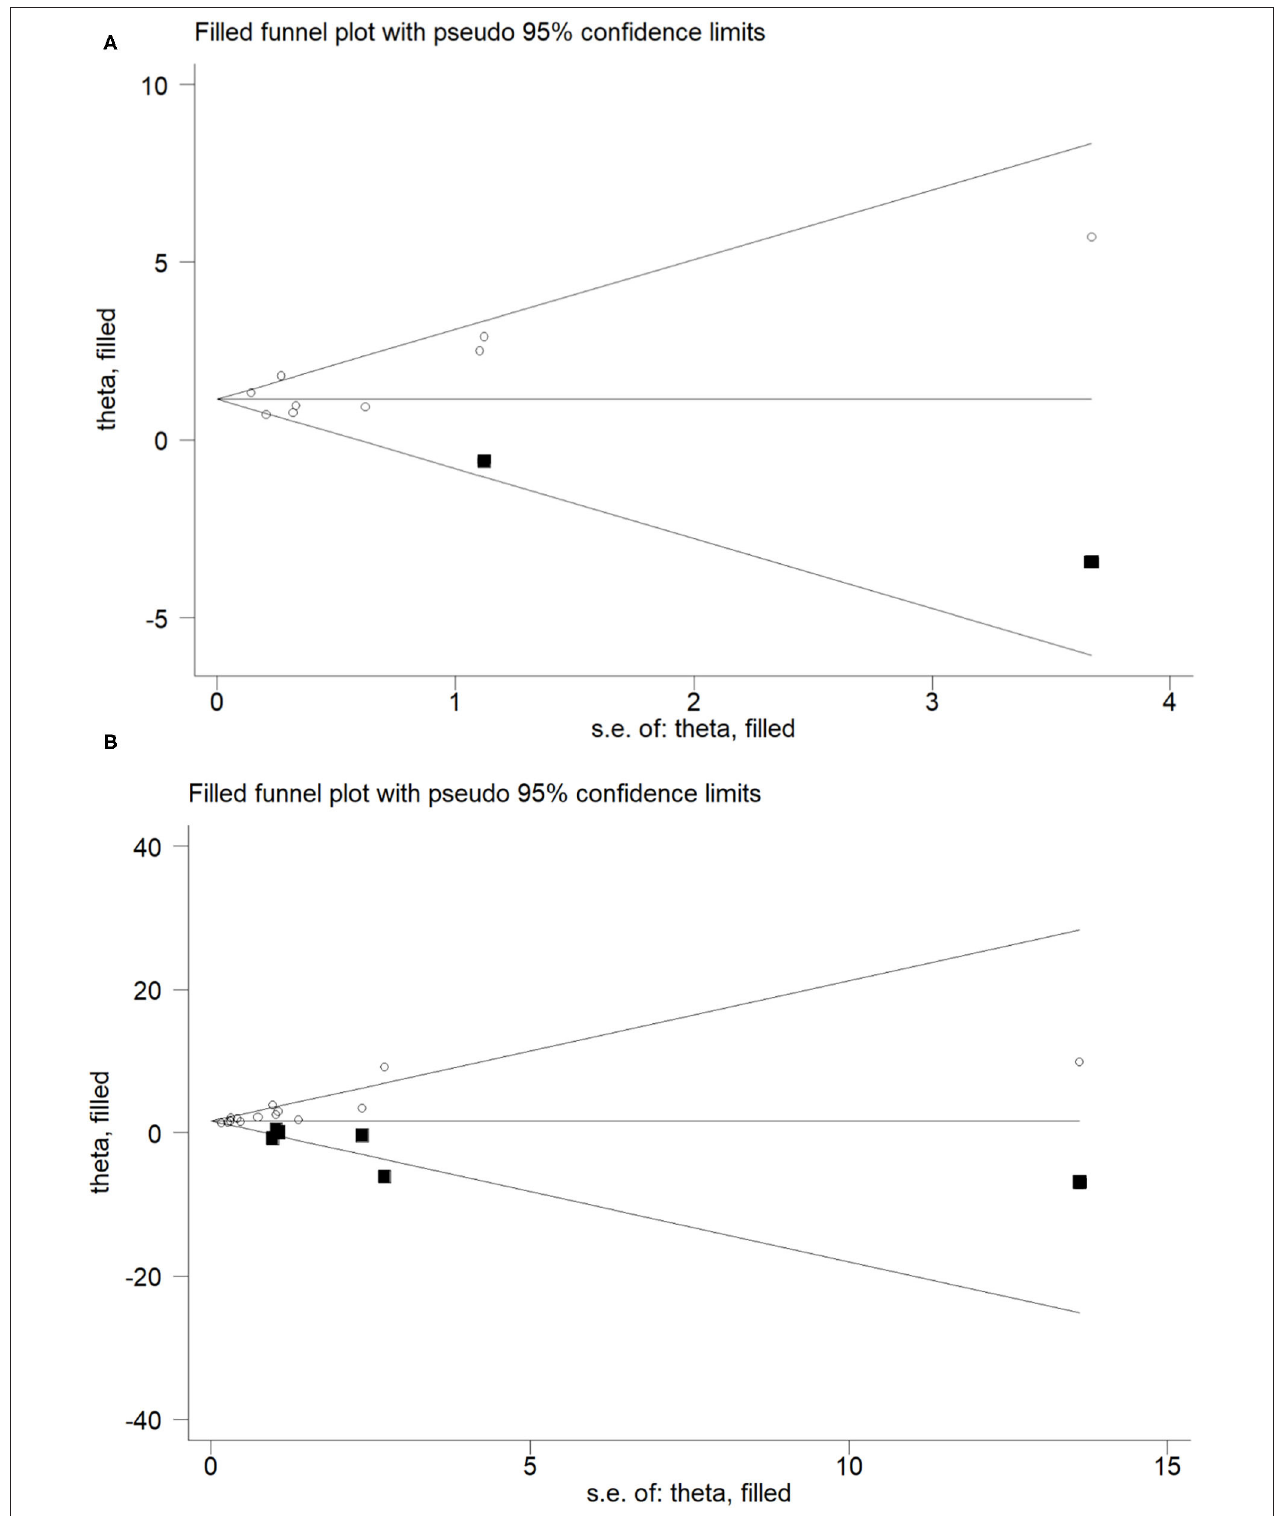
FIGURE 3 | Trim and fill funnel plot for meta-analysis of the association between Blood Cd concentration and osteoporosis or osteopenia (A) , Urinary Cd concentration and osteoporosis or osteopenia (B) .